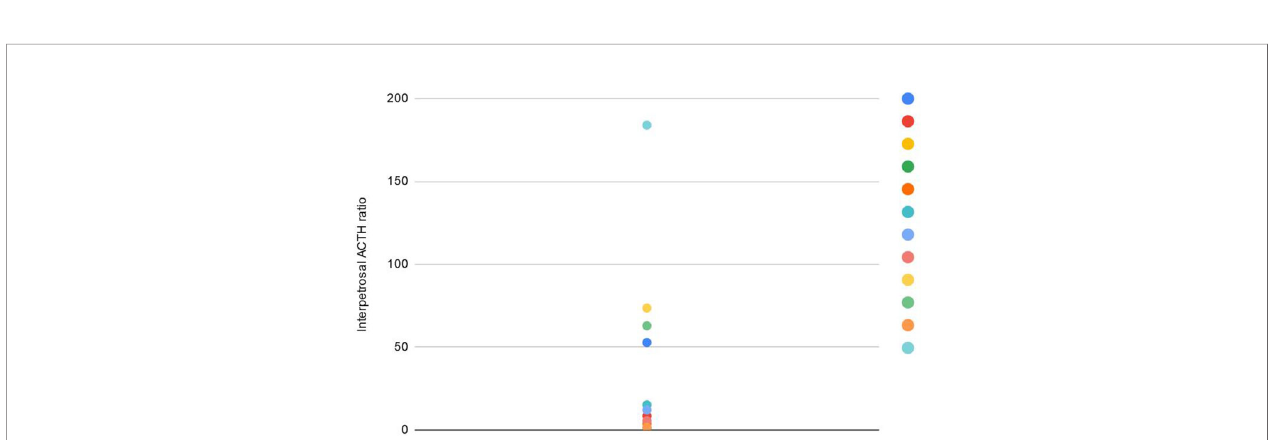
FIGURE 2 | Maximal interpetrosal ACTH ratio during BIPSS in the studied